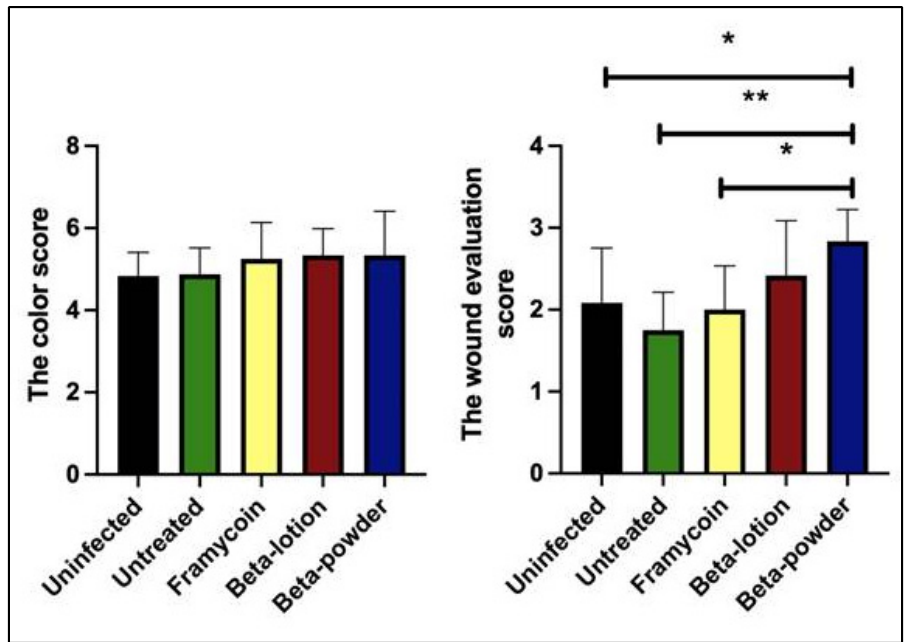
Figure 4. The wound healing evaluation. Individual wound characteristics were assigned numerical scores and the analysis for day 10 is shown. Statistical analysis was performed with the nonparametric Kruskal–Wallis test and the multiple comparison test (* p < 0.05 and ** p < 0.01). While the color characteristics alone showed no significant differences between